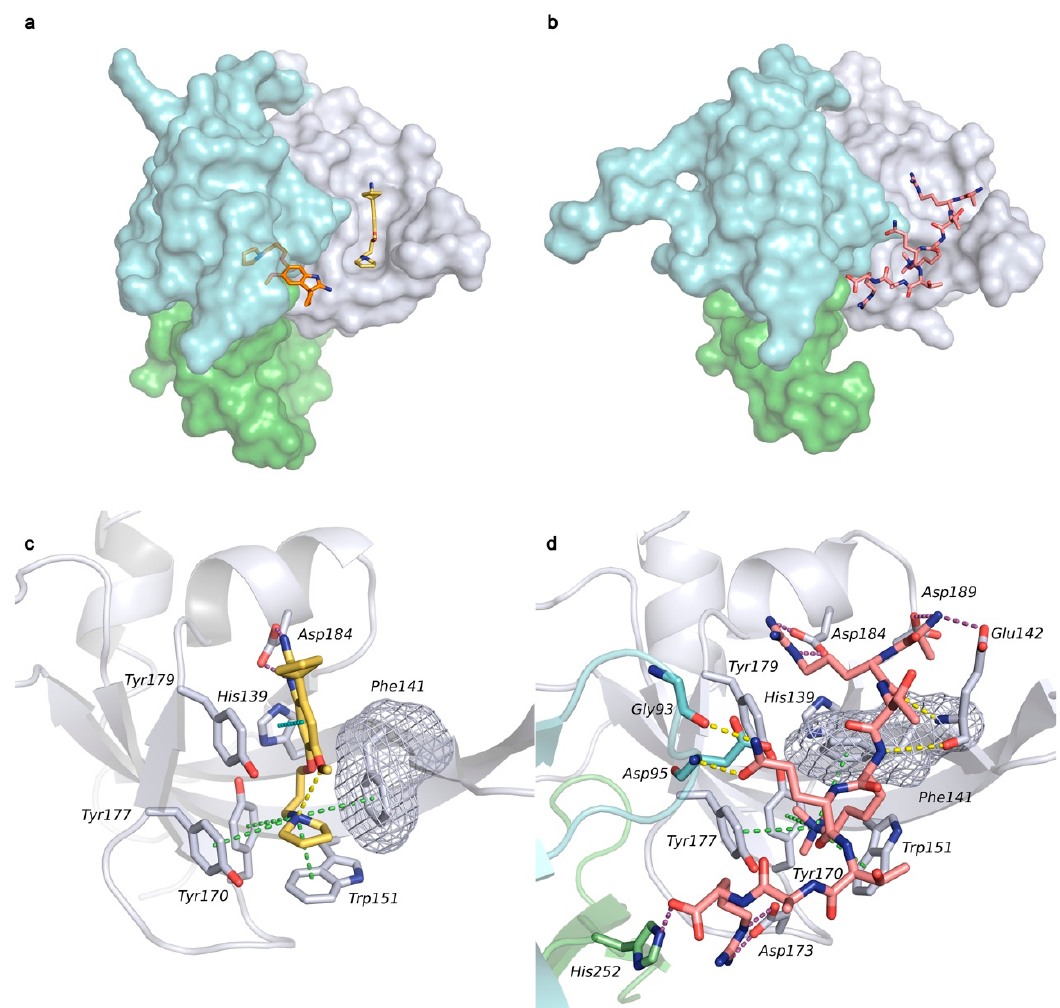
Figure 2. Crystal structures of Spindlin1 in complex with ( a , c ) A366 (PDB ID: 6I8Y) and ( b , d ) H3K4me3 (PDB ID: 4H75). ( a , b ) show the protein surfaces of the three Tudor domains, which are colored in cyan (domain I), white (domain II), and green (domain III). A366 bound to the first Spindlin1 domain is represented as orange sticks. ( c , d ) focus on domain II and the binding interactions of A366 (yellow sticks) and H3K4me3 histone peptide (pink sticks). Only the side chains of the surrounding residues are shown for clarity, and they are displayed as sticks; for residues Gly93, Asp95, and Glu142, the main chains are shown. Phe141 is also depicted by the surface mesh. Hydrogen bonds are represented as dashed yellow lines, cation–pi interactions as dashed green lines, pi–pi stacking interactions as dashed cyan lines, and salt bridges as dashed magenta